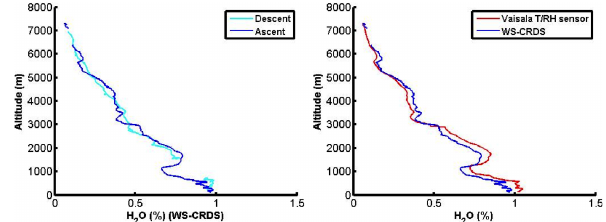
Fig. 12. Altitude profiles of water vapor (H 2 O) measurements over Galena on 28 June 2012. Left panel: ascent and descent measure- ments from the CRDS analyzer (data gaps exist during calibra- tion periods). Right panel: ascent measurements from both CRDS (blue) and calculated from in situ temperature and RH measure- ments (red).